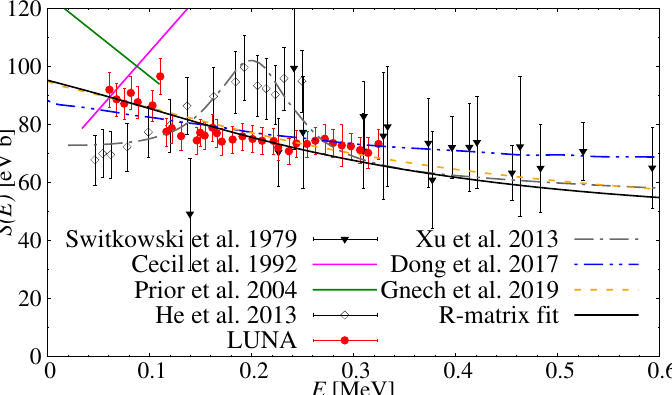
Figure 2: Astrophysical S-factor for the 6 Li( p , γ ) 7 Be reaction as obtained by LUNA in red [17]. Previous experimental data and theoretical evaluations are also shown for comparison. The solid black line represents an R-matrix fit of LUNA data and data from